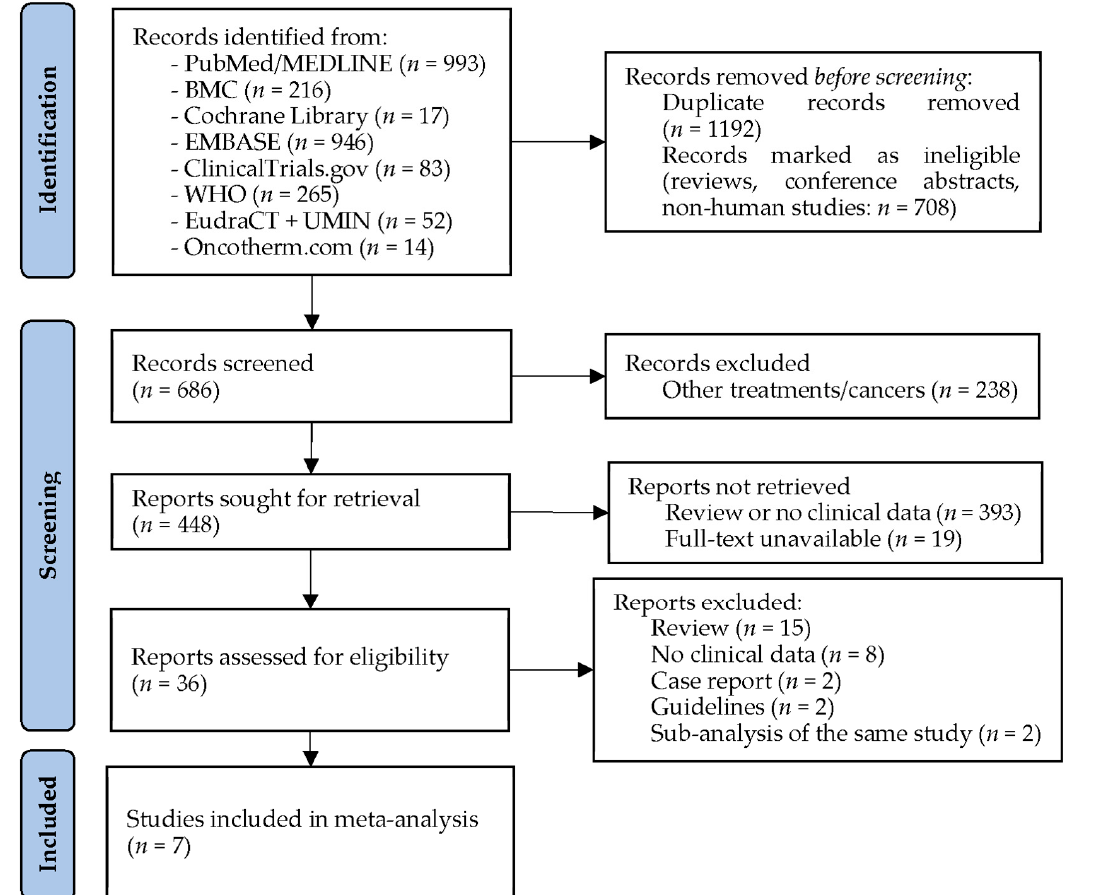
Table 1. Details of the selected studies investigating the effect of modulated electro-hyperthermia (mEHT) in glioblastoma.